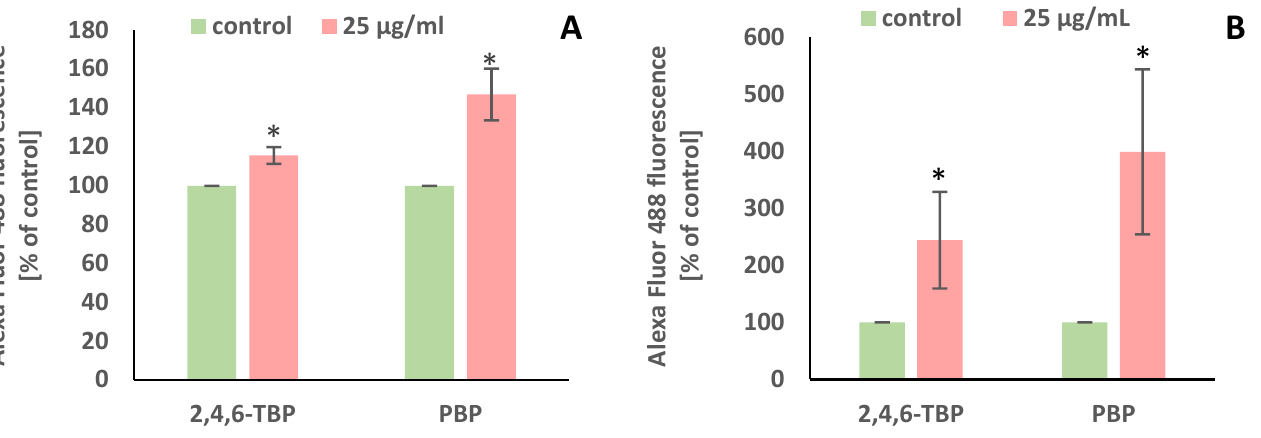
Figure 5. Changes in PARP-1 cleavage ( A ) and DNA fragmentation ( B ) in human PBMCs incubated with 2,4,6-TBP and PBP in the concentration of 25 µ g/mL for 24 h. Means ± SDs were calculated